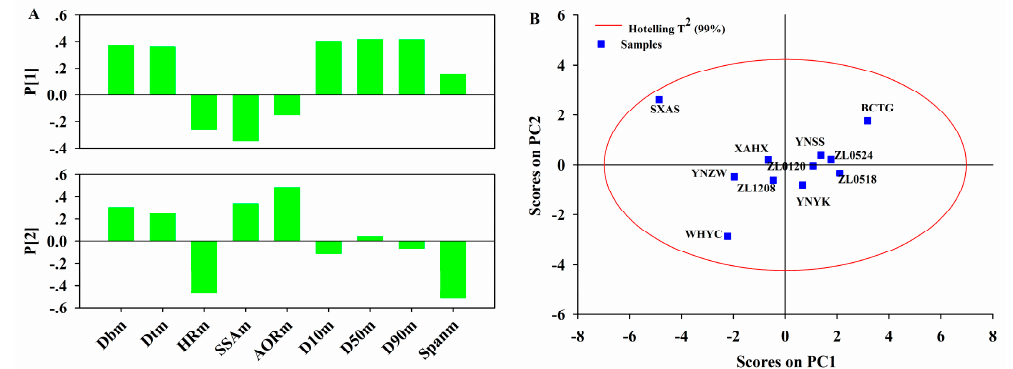
Figure 5. ( A ) Loading bar plots of PCA model on Block M; ( B ) Score plot of PCA model on Block M .